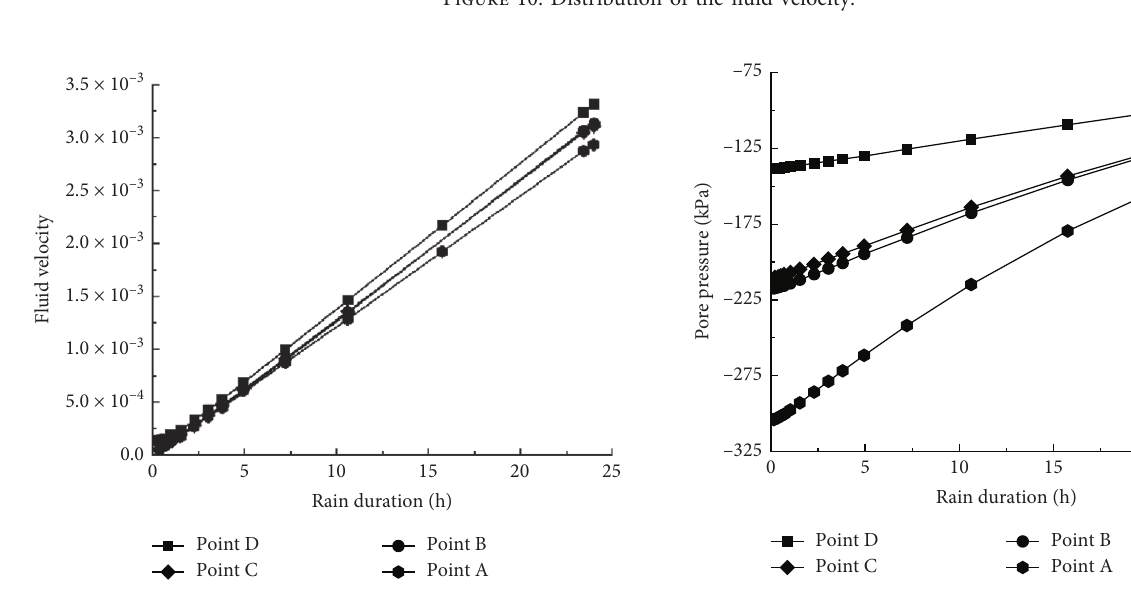
Figure 10: Distribution of the fluid velocity.